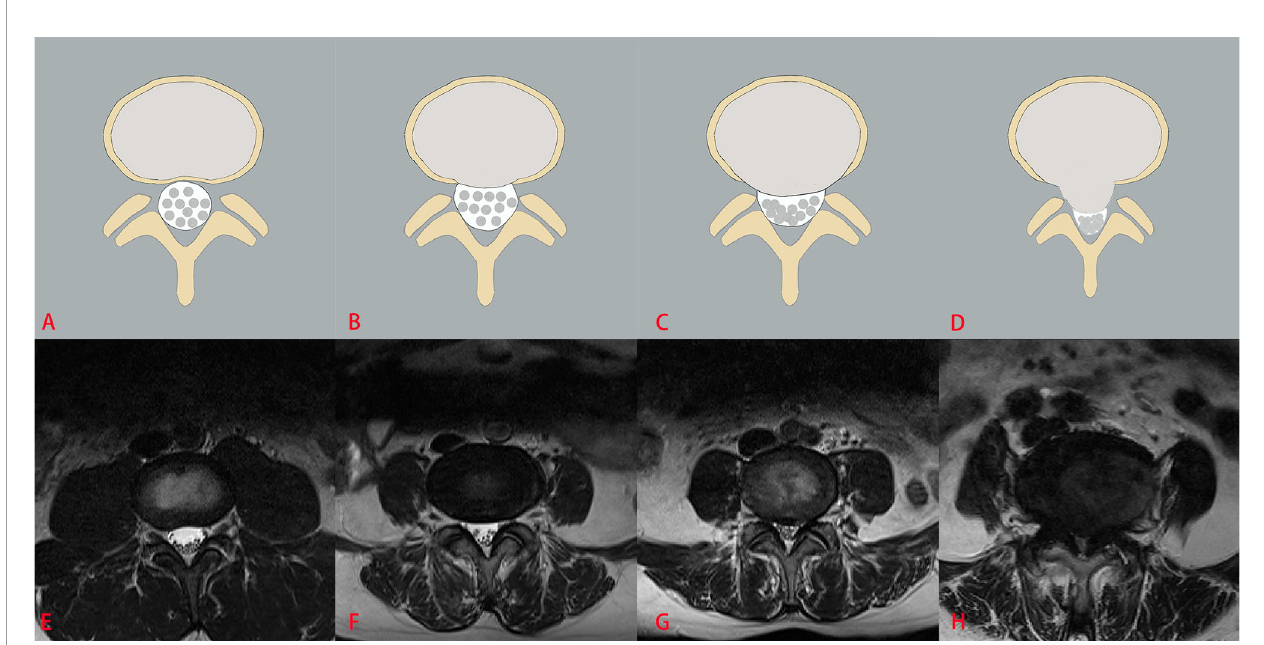
FIGURE 3 | The classi fi cation system of lumbar central canal stenosis (LCCS). The top column is a schematic diagram of four grades with LCCS, and the bottom column is the corresponding axial T2W TSE images of four grades with LCCS. LCCS is divided into four grades according to the obliterated severity of anterior cerebrospinal fl uid space: Grade 0 (A, E) normal; Grade 1 (B, F) minor stenosis with clear separation of each cauda equina nerve roots; Grade 2 (C, G) moderate stenosis with some cauda equina nerve roots combination; Grade 3 (D, H) severe stenosis with all cauda equina nerve roots as a